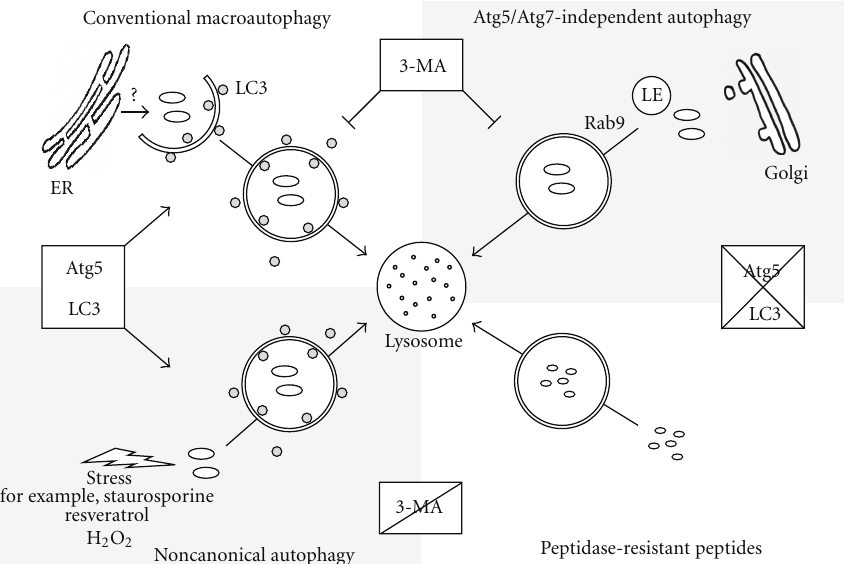
Figure 1: Alternative macroautophagic pathways lead to lysosomal degradation. At least four autophagic pathways can be distinguished that all show double-membrane autophagic structures and end in lysosomal degradation of cytoplasmic cargo. Conventional macroautophagy is hallmarked by the recruitment of lipidated LC3 to autophagosomal membranes that may origin from the endoplasmatic reticulum (ER). This process is dependent on Atg5 and Beclin 1 and can be inhibited by 3-methyladenine (3-MA). In contrast, the observed Atg5/Atg7- independent autophagy pathway forms Rab9-positive double-membrane vesicles derived from the trans -Golgi network and late endosomes (LE), and while it can be inhibited by 3-MA and is dependent on Beclin 1, the process is independent of Atg5 and LC3. Almost similar, the degradation of accumulated peptidase-resistant peptides is independent of Atg5 and LC3 and is also insensitive to 3-MA treatment. Finally, the noncanonical autophagy pathway induced by di ff erent stress factors is dependent on Atg5 and LC3 and independent of Beclin 1 but cannot be impaired by